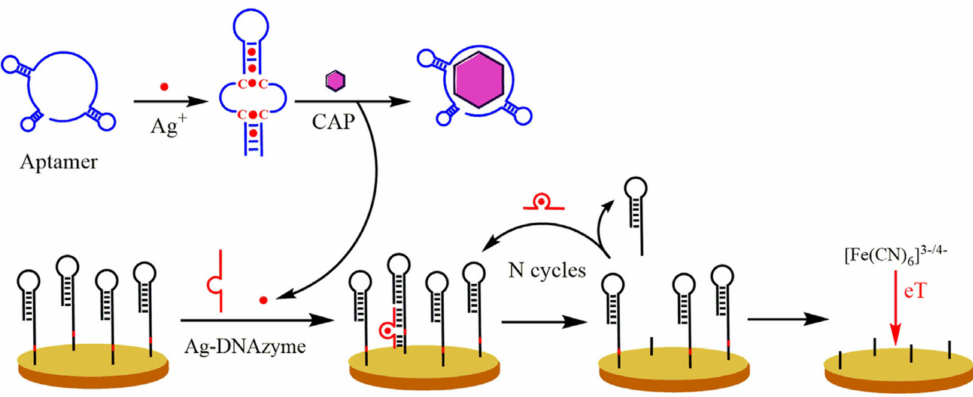
Figure 8. Principle of the aptasensors based on an Ag-DNAzyme for the detection of chloramphenicol (CAP). Reprinted from [37] with permission from